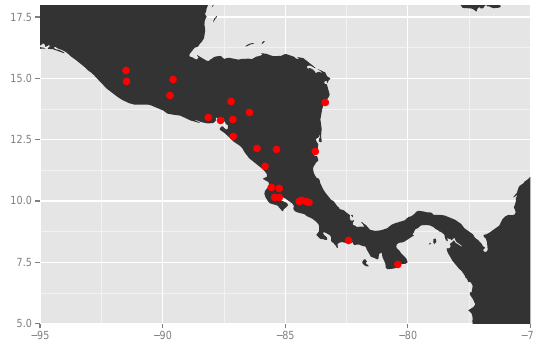
Figure 1. Spatial distribution of the gauge stations in Central Amer-